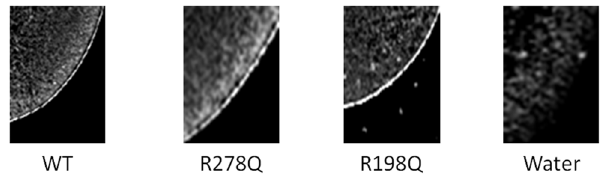
Figure 8. Fluorescence staining of MCT4 in slices of oocytes. Localization of hMCT4 in oocytes injected with hMCT4-WT or the indicated mutants. Oocytes were treated with antibodies against MCT4. Data shown are typical results of three independent